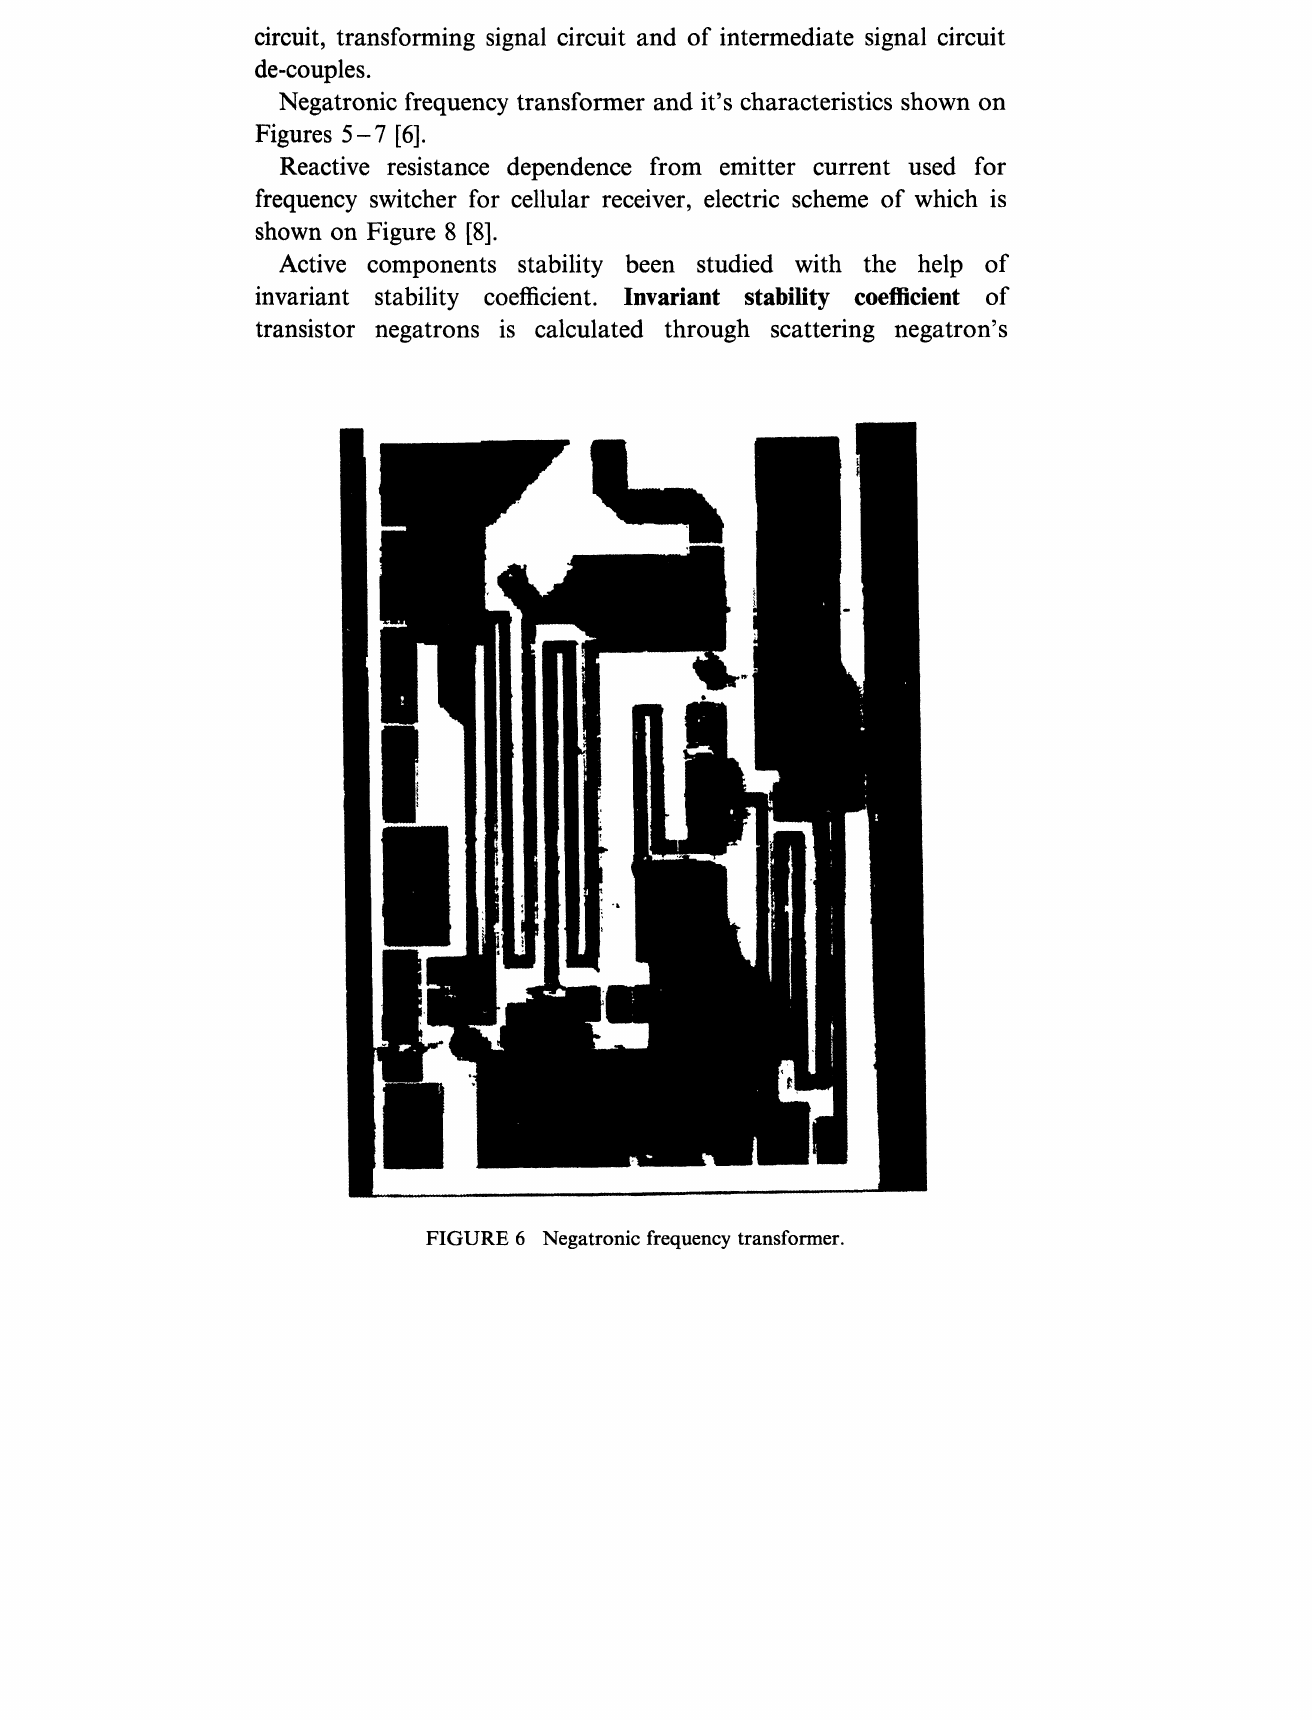
FIGURE 6 Negatronic frequency